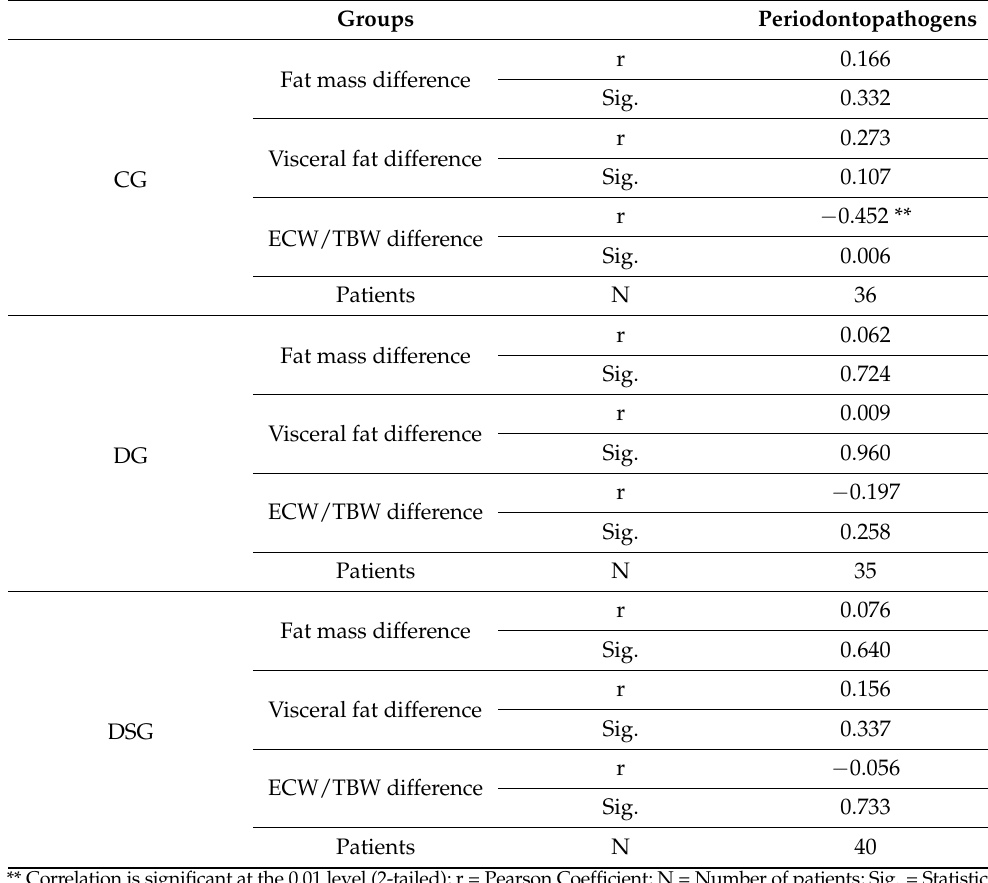
Table 6. Pearson correlation between the evolution of periodontitis and grease mass and ECW/TBW in all three research